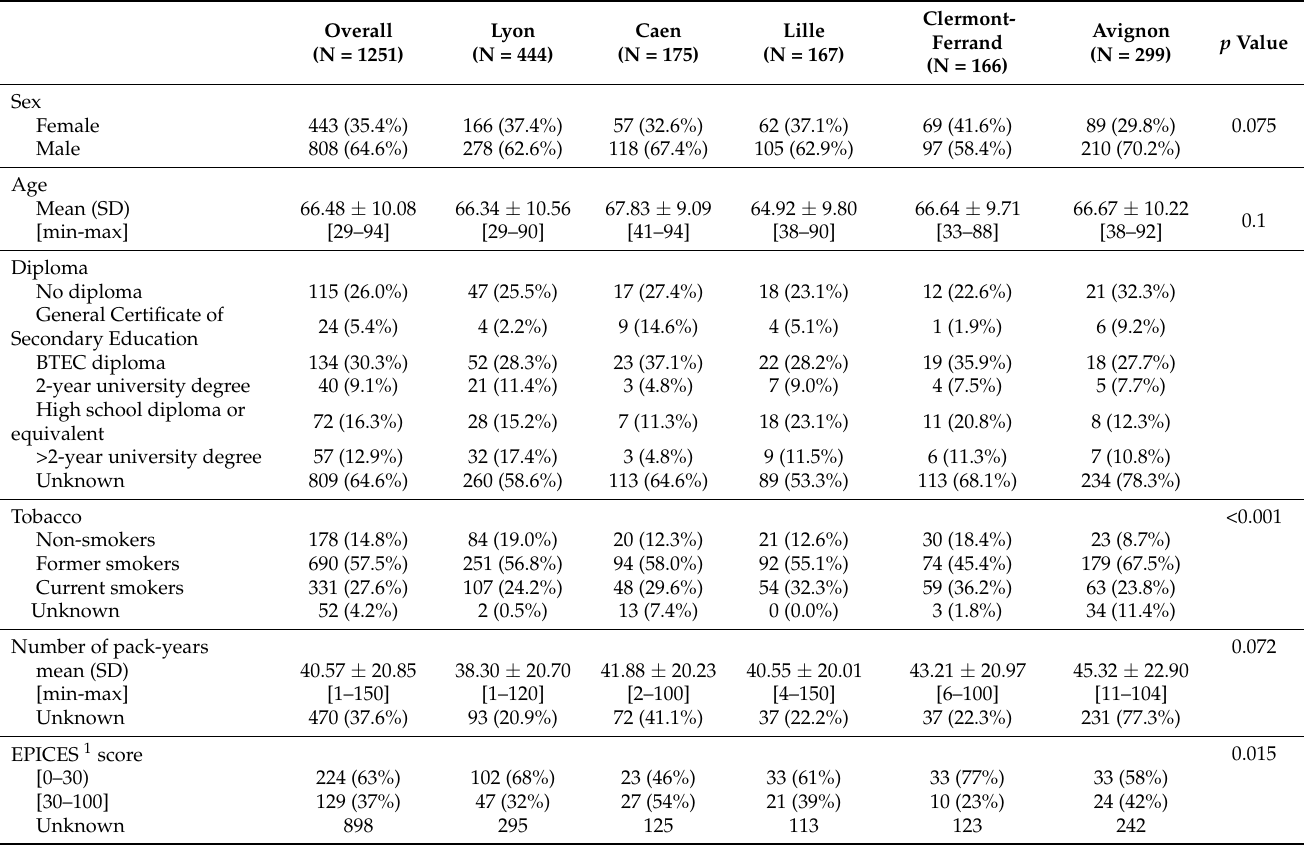
Table 1. Demographic characteristics of PROPOUMON national patients, globally and per center,